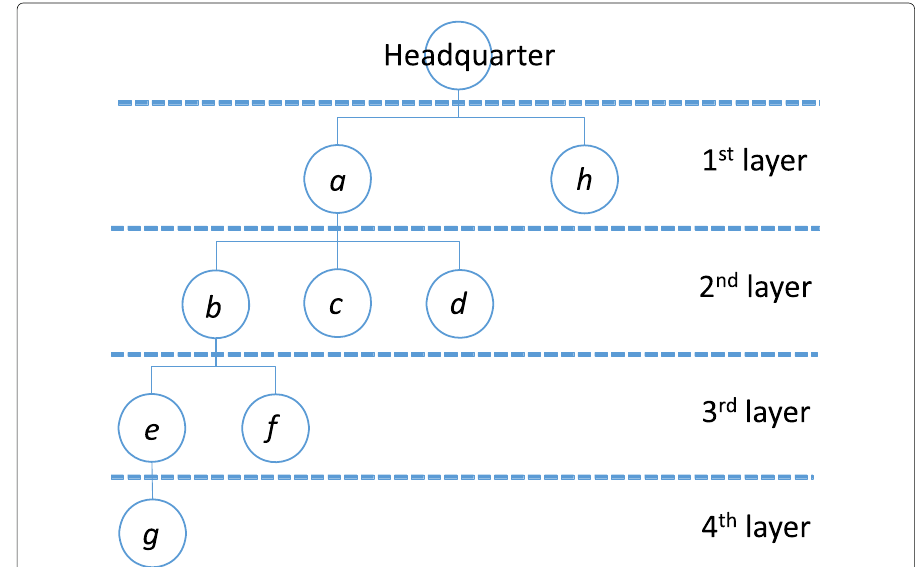
Fig. 4 Ownership structure of MNC M . the circles indicate the headquarter and its affiliates; the lines indicate the substantial ownership links; the labels indicate the name of the affiliates; and the dotted lines indicate the division the ownership